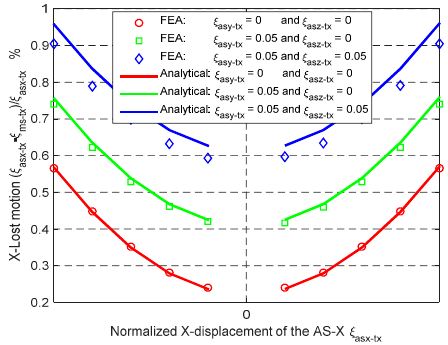
Figure 12. Analytical result and FEA result comparison regarding the relationship between the normalized X ms -axis primary translation of the AS-X and the X ms -axis lost motion under the different conditions.